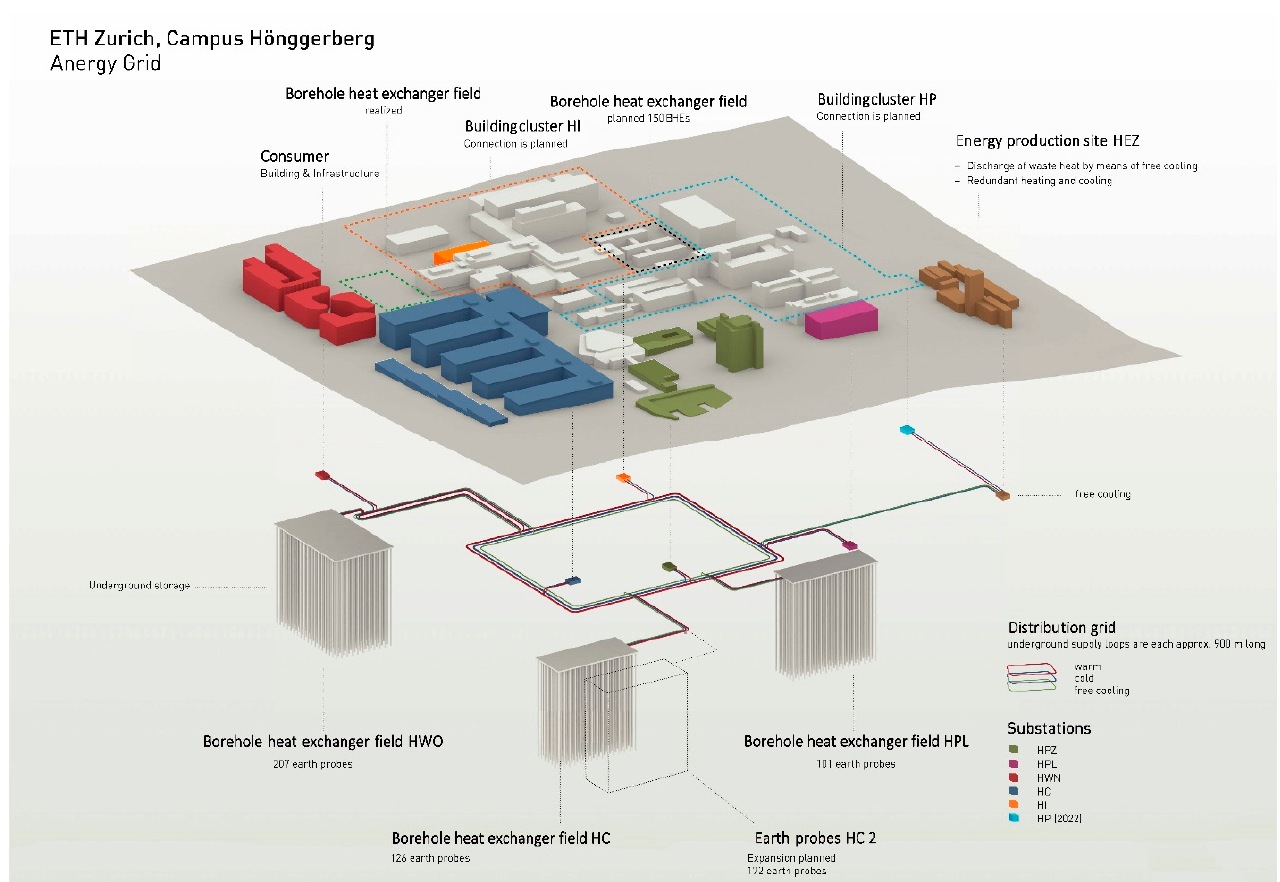
Figure 23. The largest Swiss GHP system with BHEs, currently in Zurich. For details, see https://ethz.ch/en/the-eth-zurich/sustainability/campus/environment/energy/anergy-grid.html (accessed on 15 September 2018).